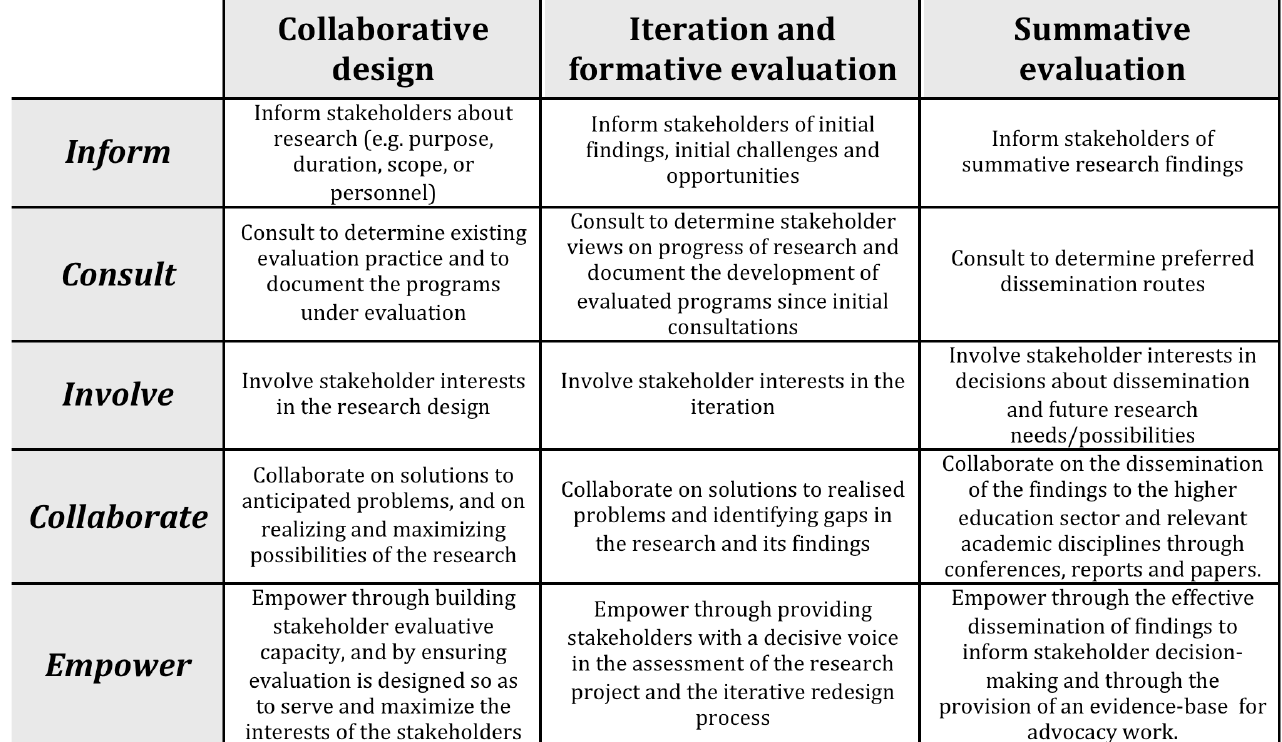
Figure 2: Evaluative research against the five ‘goals’ of community